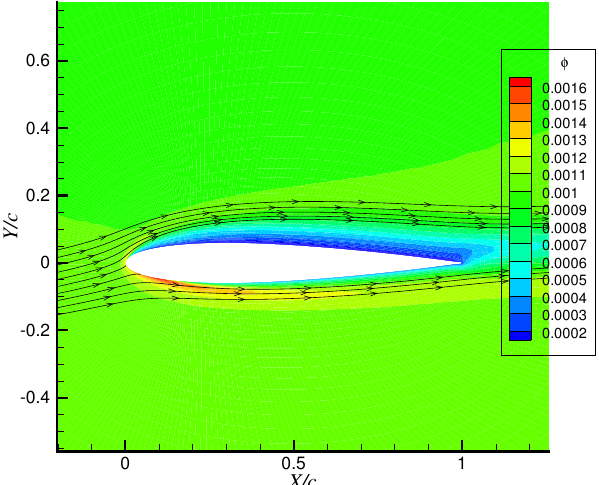
Figure 12. Liquid water content calculated by the tightly-coupled method.